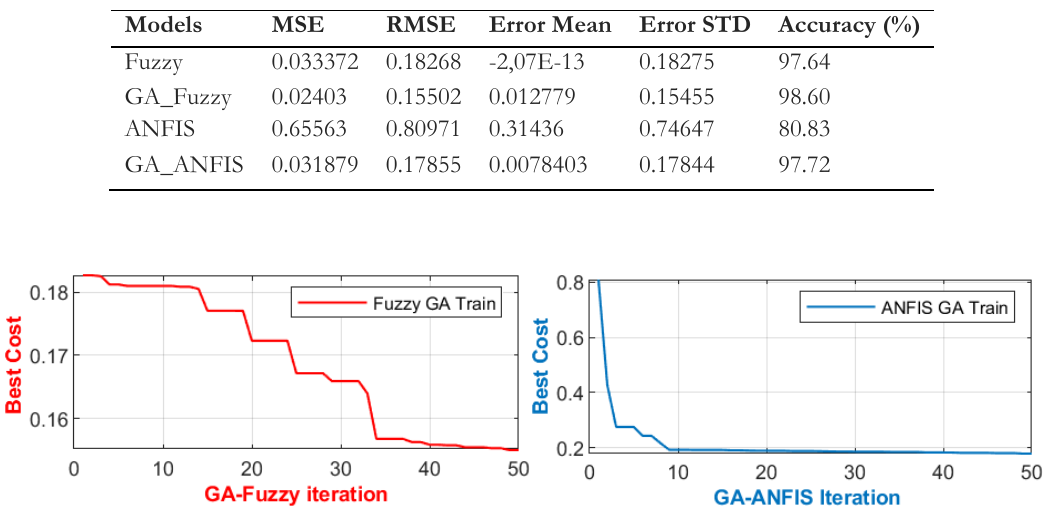
Fig. 4. Diagram of the best cost of the proposed GFS model.